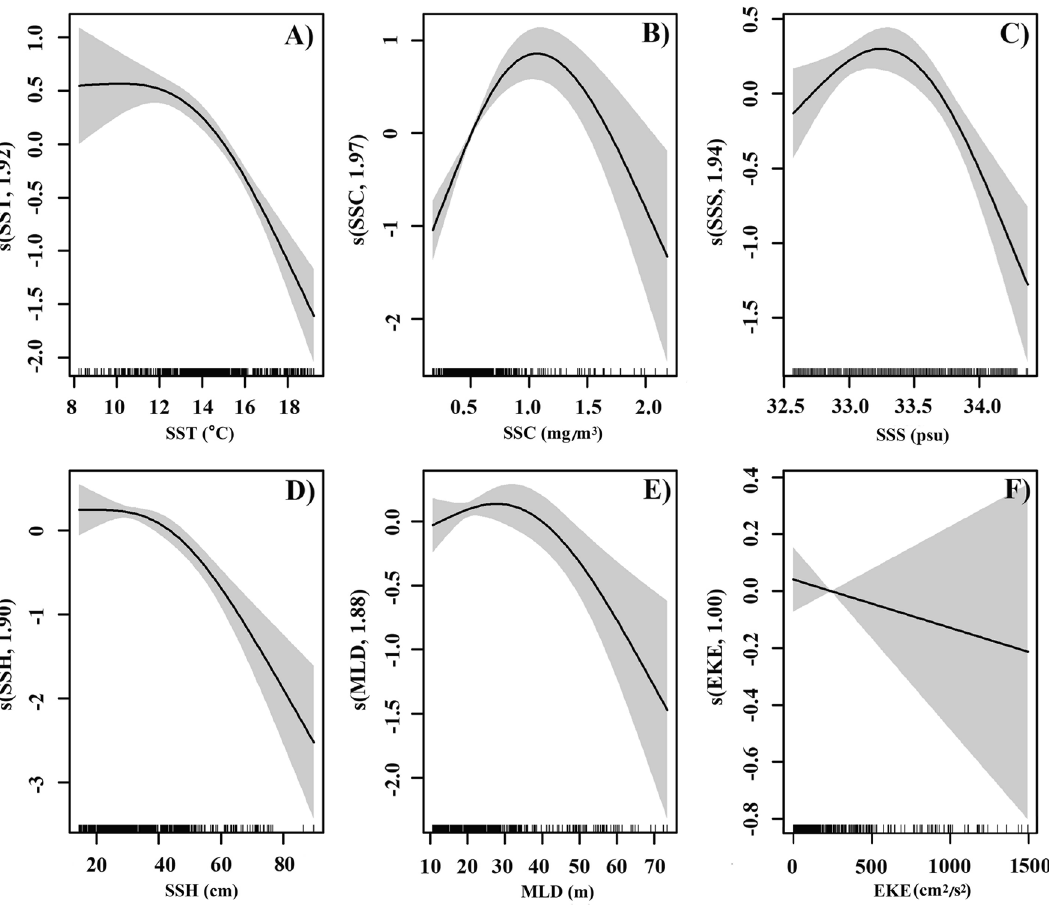
Figure 8. GAM-derived effects of the oceanographic variables on CPUE 1 , from models constructed for: ( A ) SST, ( B ) SSC, ( C ) SSS, ( D ) SSH ( E ) MLD, and ( F ) EKE. Rug plots on the horizontal axis represent observed data points, and the fitted function is shown by the solid line. The grey-shaded areas show the 95% confidence